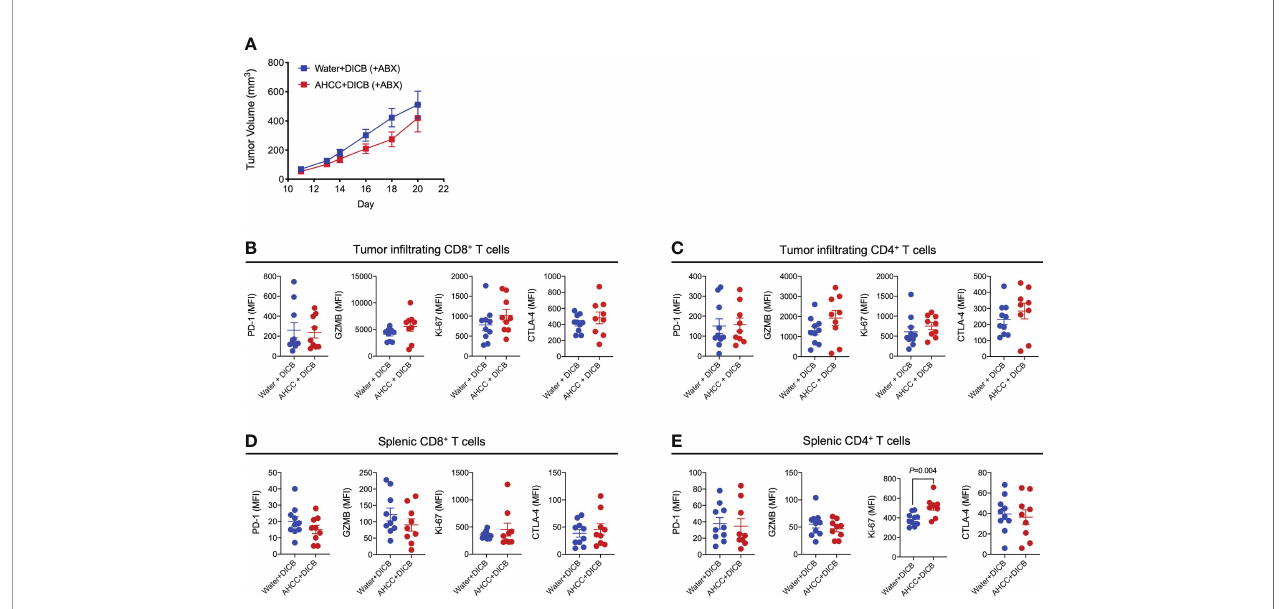
FIGURE 4 | Administration of antibiotics abrogates the additive anti-tumor effect of AHCC ® in MC38 tumor-bearing mice treated with dual PD-1/CTLA-4 blockade. Mice were treated for approximately 3 weeks prior to subcutaneous MC38 tumor inoculation with a combination of 3 antibiotics (ampicillin, streptomycin, and colistin) by adding the drugs to drinking water and continued until sacri fi ce. As described in Figure 1A , tumor bearing mice were subsequently treated with water or AHCC ® in addition to dual PD-1/CTLA-4 blockade i.p. injection (50 µg each, twice at 3-day intervals). (A) Tumor growth was determined by measuring tumor volume (mm 3 ). Flow cytometric analysis of PD-1, granzyme B (GZMB), Ki-67, and CTLA-4 expression (mean fl uorescent intensity or MFI) by tumor-in fi ltrating (B, C) and splenic (D, E) CD8 + and CD4 + T cells. Each dot indicates one mouse (n =9-10/group). Lines and error bars indicate mean ± standard error of mean (SEM), respectively. Data from two independent experiments. P values were determined using the unpaired Student ’ s t